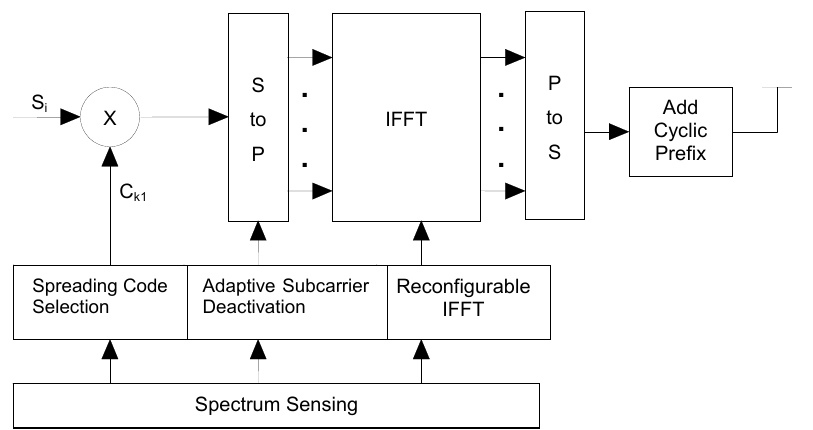
Figure 5. Reconfigurable MC-CDMA